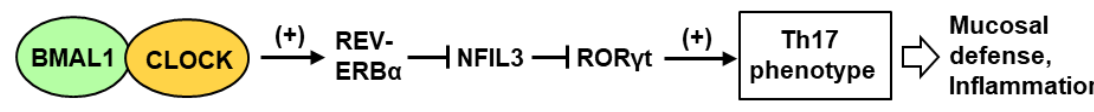
Figure 3. Cascade positive and negative transcriptional steps in clock-regulated IL-17-producing Th17 response [107]. The circadian clock BMAL1-CLOCK heterodimer transcriptionally activates the REV-ERBα gene (as in Figure 1). The REV-ERBα protein then represses the synthesis of the next transcription factor, NFIL3, which in turn represses the gene for RORγt, an orphan nuclear receptor, essential for Th17 cell specification.